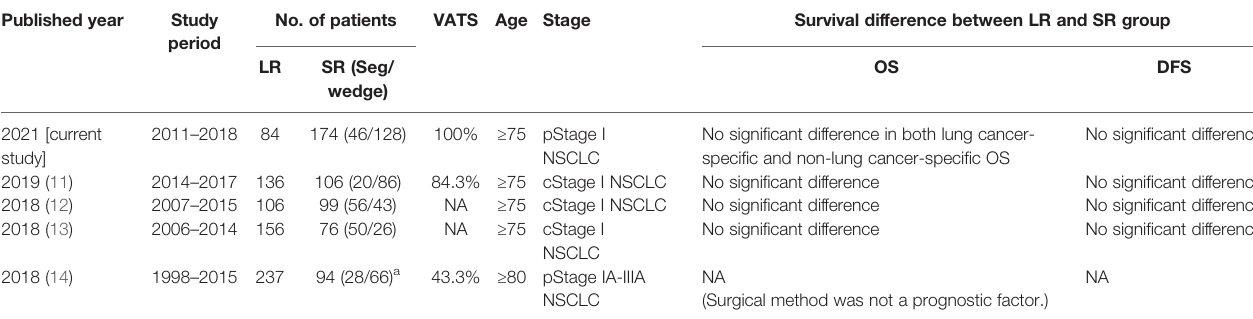
TABLE 4 | Summary of studies discussing the survival correlation of lobectomy vs. sublobar resection in patients with geriatric early-stage lung cancer in recent 5